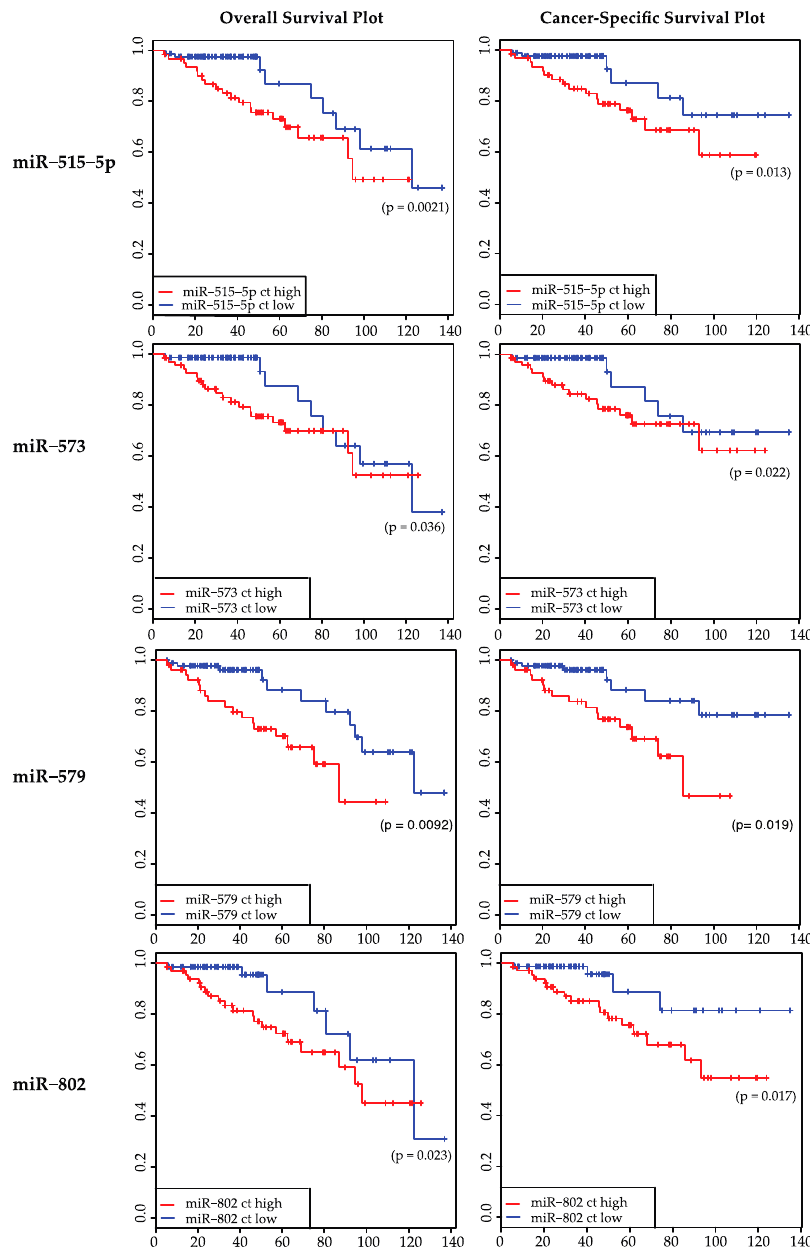
Figure 1. Correlation of miR-515-5p, miR-573, miR-579, and miR-802 to overall survival an cancer-specific survival. Overall survival ( left ) and cancer-specific survival ( right ) of a set of 147 patients are illustrated as Kaplan-Meyer-curves for miR-515-5p, -573, -579, and -802. Red curve represents patients with a high expression of the mentioned miRNAs, blue curve those with a low expression. In all shown cases a high expression of the corresponding miRNA is significantly associated with a worse overall survival and cancer-specific survival.